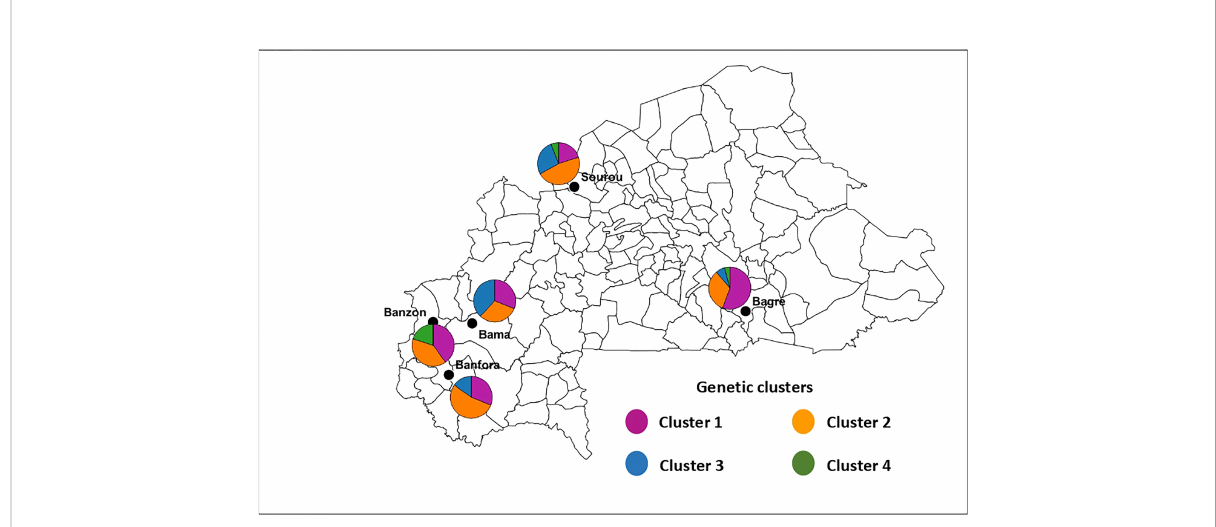
FIGURE 5 Geographic distribution of the four genetic clusters of Exserohilum rostratum in Burkina Faso. The size of sectors is proportional to the proportion each cluster de fi ned by DAPC in each area. Cluster 1 (n = 58 isolates), Cluster 2 (n = 60 isolates), Cluster 3 (n = 26 isolates) and Cluster 4 (n = 7